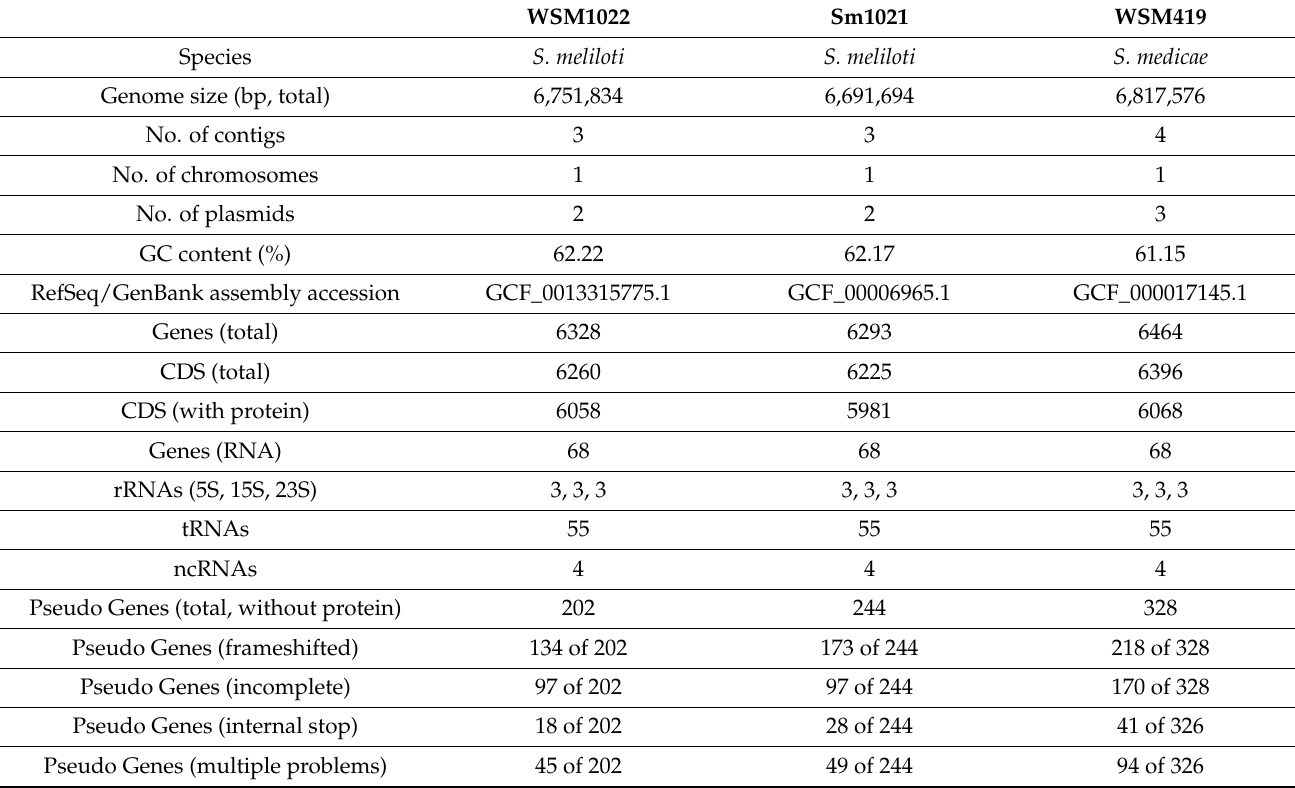
Table 1. Comparison of general genome features of the rhizobial strains in this study. WSM1022 Sm1021 WSM419 Species S. meliloti S.